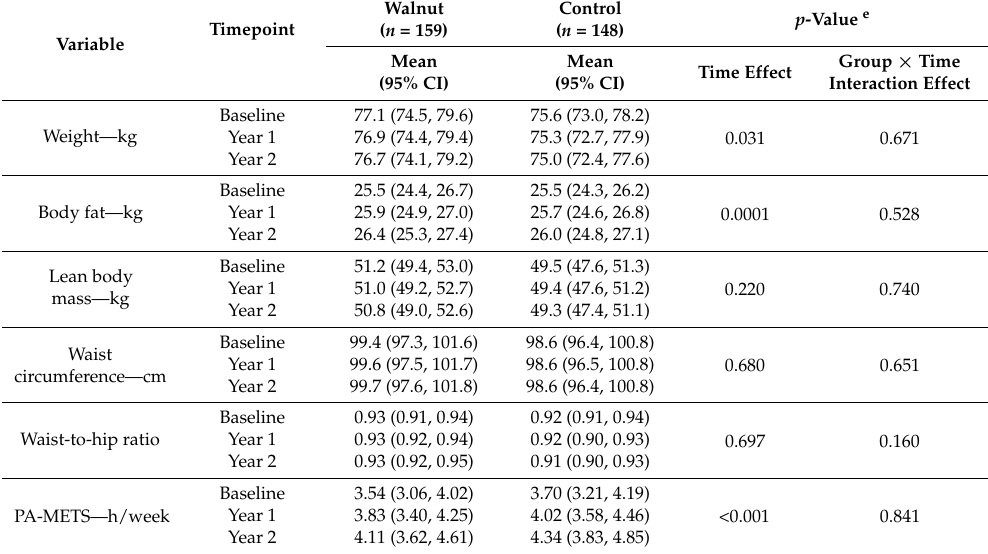
Table 3. Adiposity and physical activity during the 2-year follow-up by intervention group.